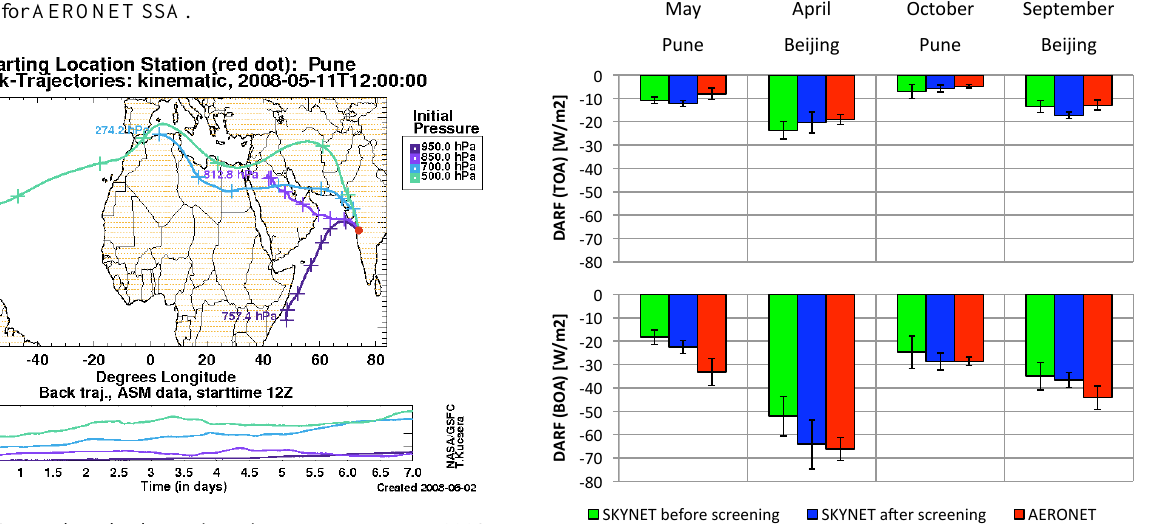
Fig. 18. Values of Direct Aerosol Radiative Forcing (DARF) de- rived by SKYNET before and after screening, and by AERONET in spring and autumn at Pune (May and October) and at Beijing (April and September) at the top of atmosphere (TOA) and the bottom of atmosphere